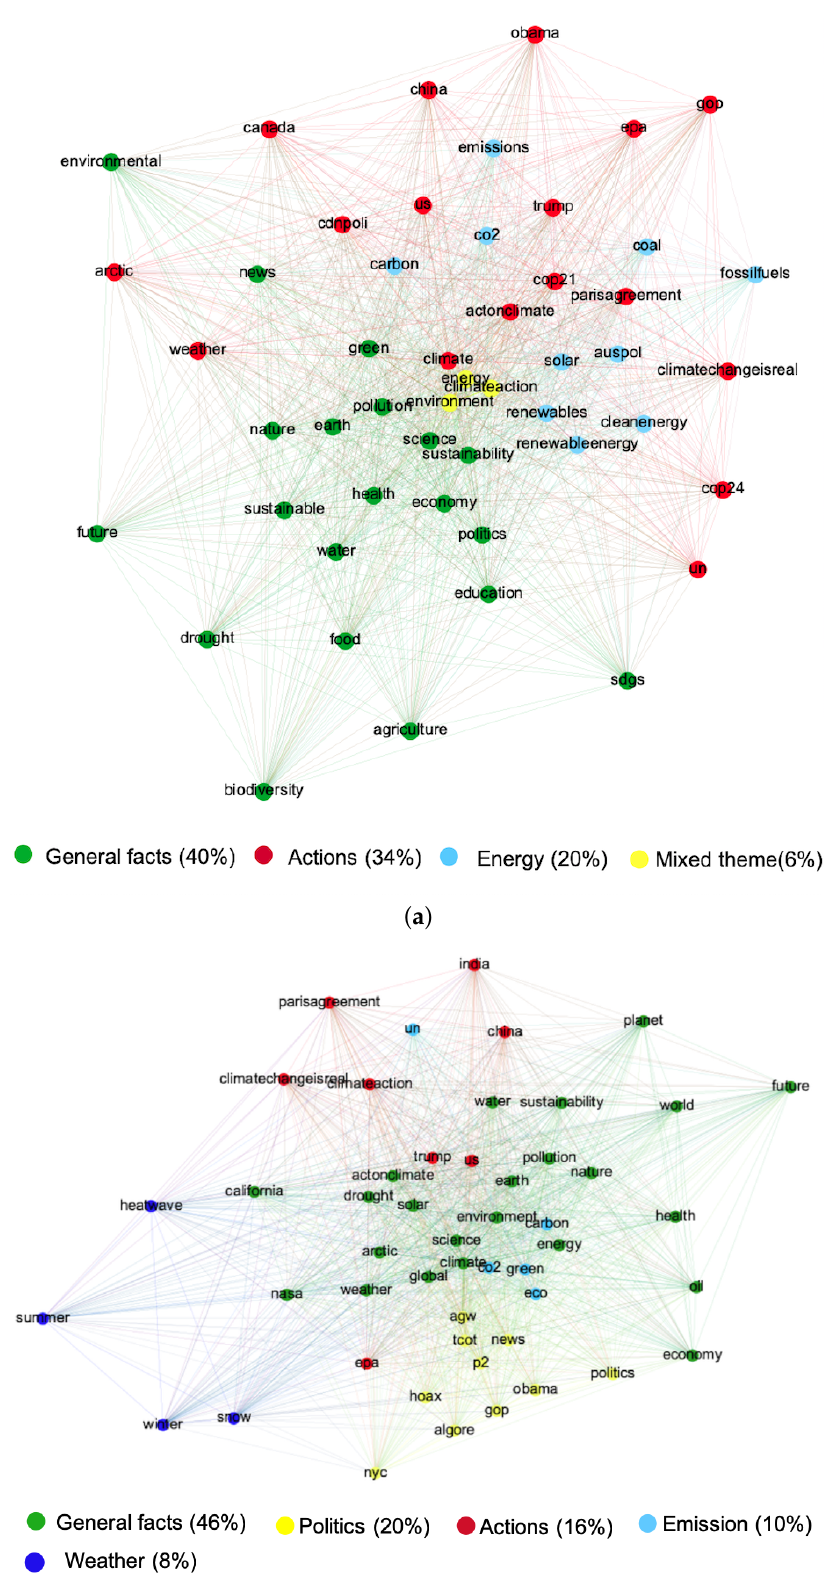
Figure 2. Association network of climate change discourse ( a ), and ( b ) association network of global warming discourse (b) .